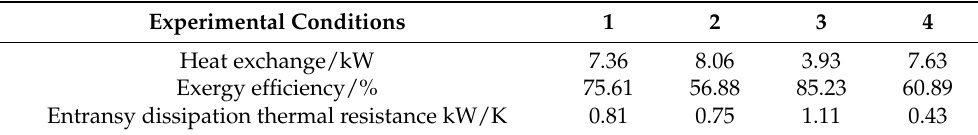
Table 6. Calculation results of thermodynamic evaluation